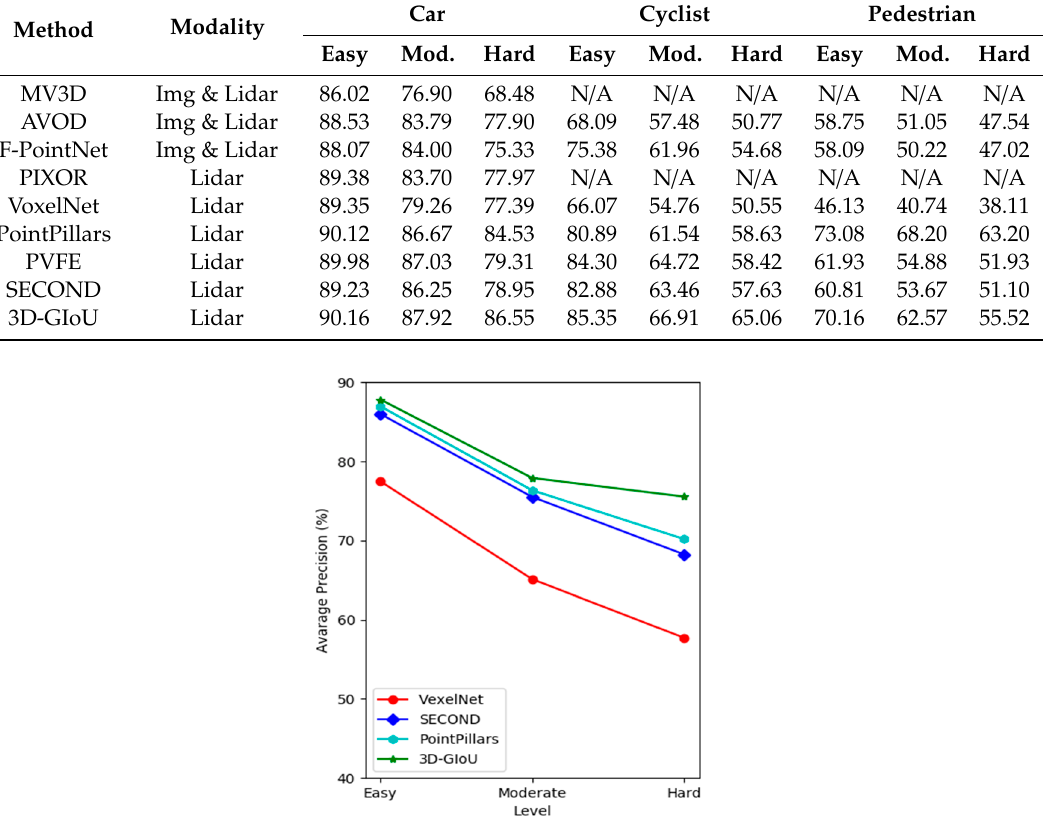
Figure 6. The AP of different methods on KITTI validation set with the different difficulty level (car detection).